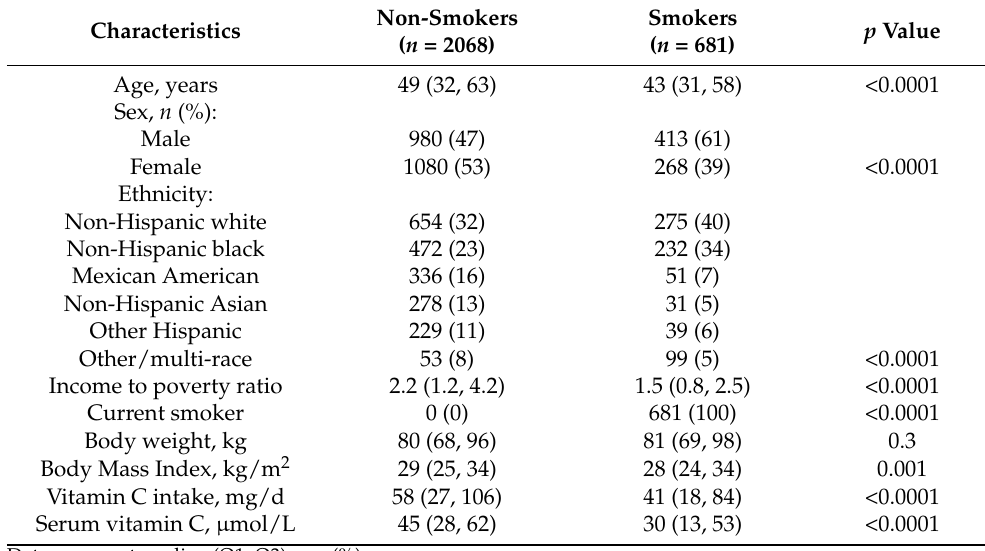
Data represent median (Q1, Q3) or n (%).